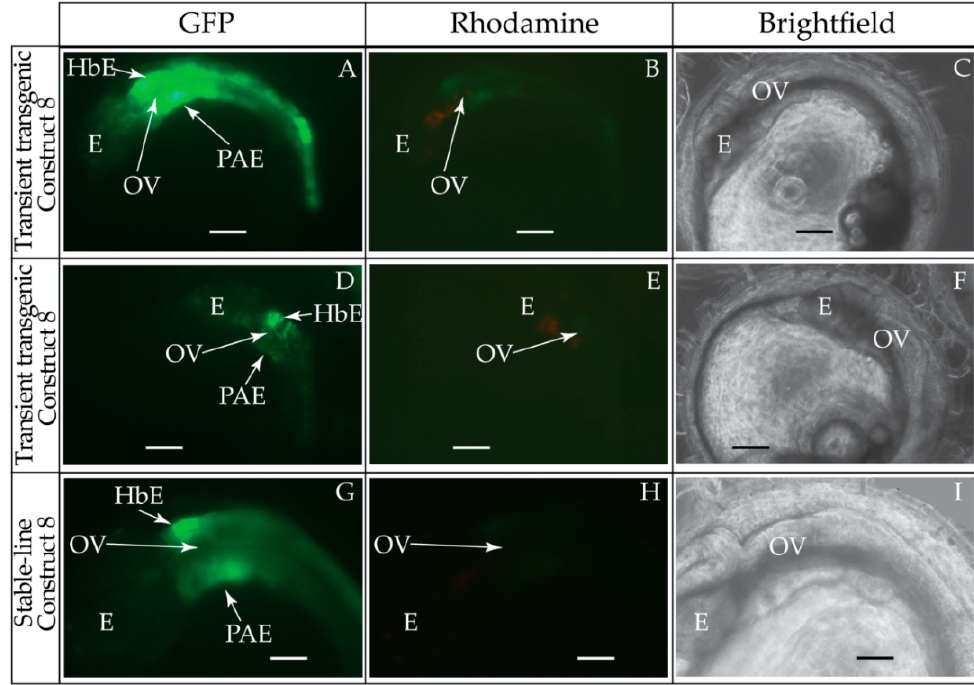
Figure 6. Transient ( A – F ) and stable-line ( G – I ) transgenic data from the medaka ψ hoxa2b UER(K20-RE5)-(Construct #8). ( A – I ) Images of transient transgenic embryos at stage 29/30 (72–84 hpf) were taken using: GFP ( A , D , G ); rhodamine ( B , E , H ); and brightfield ( C , F , I ) filters. Transient transgenic analyses show varying degrees of eGFP signal between embryos (compare A and D ). All embryos are still in their chorions and are positioned with their anterior sides to the left and their lateral sides to the reader. E, eye; HbE, hindbrain expression; OV, otic vesicle; PAE, pharyngeal arch expression. Scale bars equal 0.1 mm.